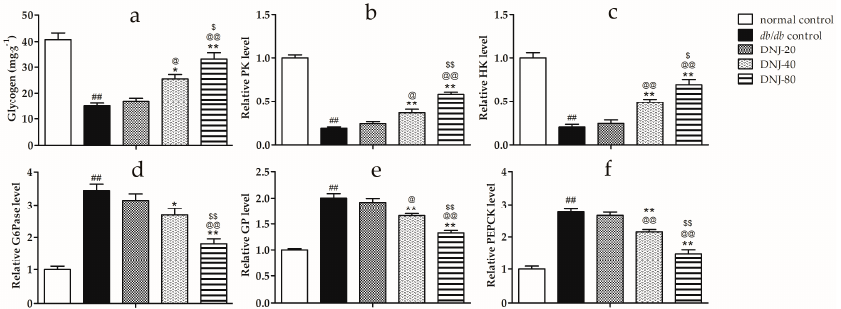
Figure 6. Effect of DNJ on hepatic glycogen content in db/db mice ( a ) and levels of pyruvate kinase (PK) ( b ); hexokinase (HK) ( c ); glucose-6-phosphatase (G6Pase) ( d ); phosphorylase (GP) ( e ); and phosphoenolpyruvate carboxykinase (PEPCK) ( f ) in the liver tissue of db/db mice. ## p < 0.01 vs. normal control. * p < 0.05, ** p < 0.01 vs. db/db control, @ p < 0.05, @@ p < 0.01 vs. DNJ-20, $ p < 0.05, $$ p < 0.01 vs. DNJ-40 ( n = 6).